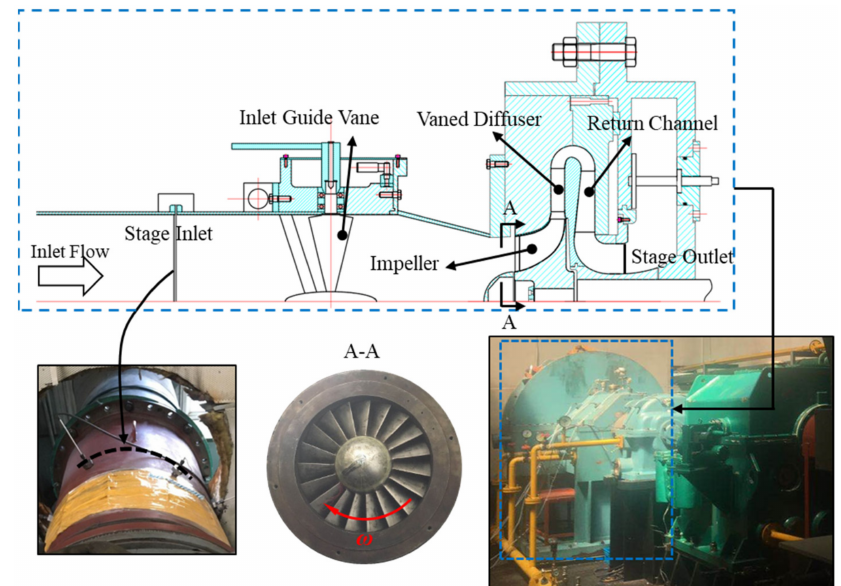
Figure 3. Schematic sketch of the experimental